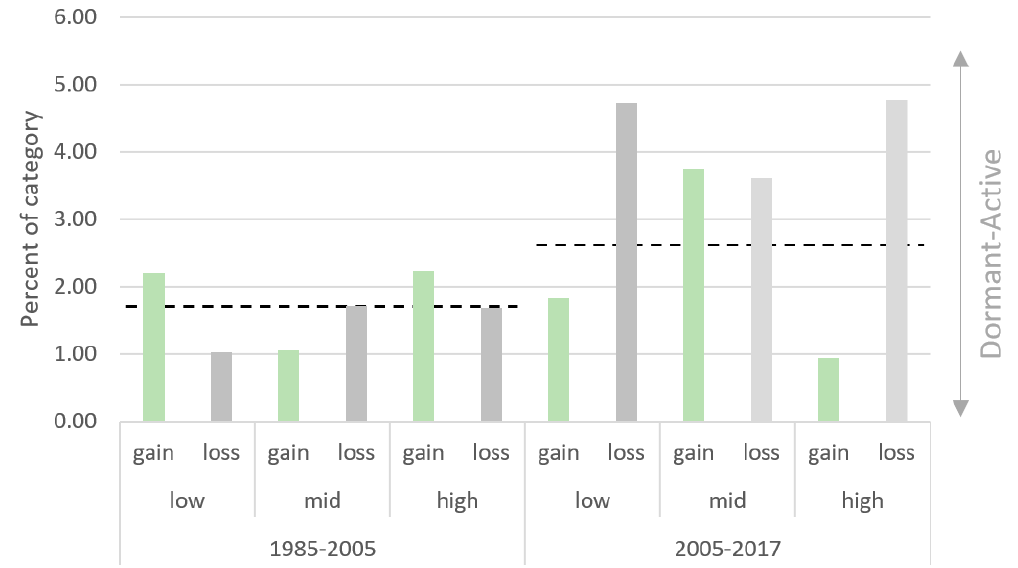
Figure 5. Category level gains and losses for three imperviousness classes (dashed lines represent the threshold of uniform intensity across the spatial extent for each time interval).